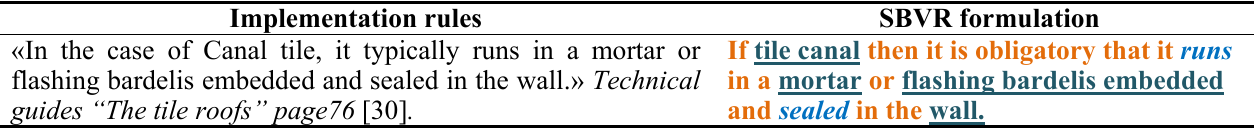
Table 3. Transforming implementation rules into SBVR